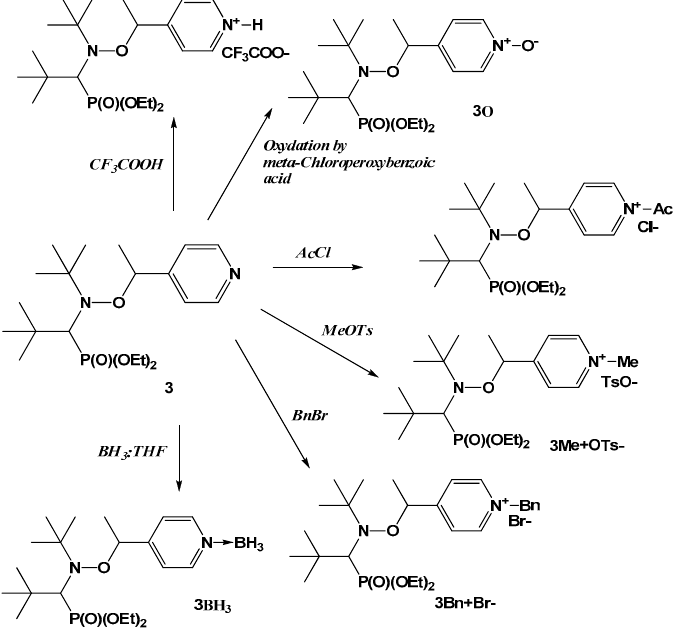
Figure 12. Structures of alkoxyamine 3 derivatives. Adapted with permission from Ref. [51]. Copyright 2012 American Chemical